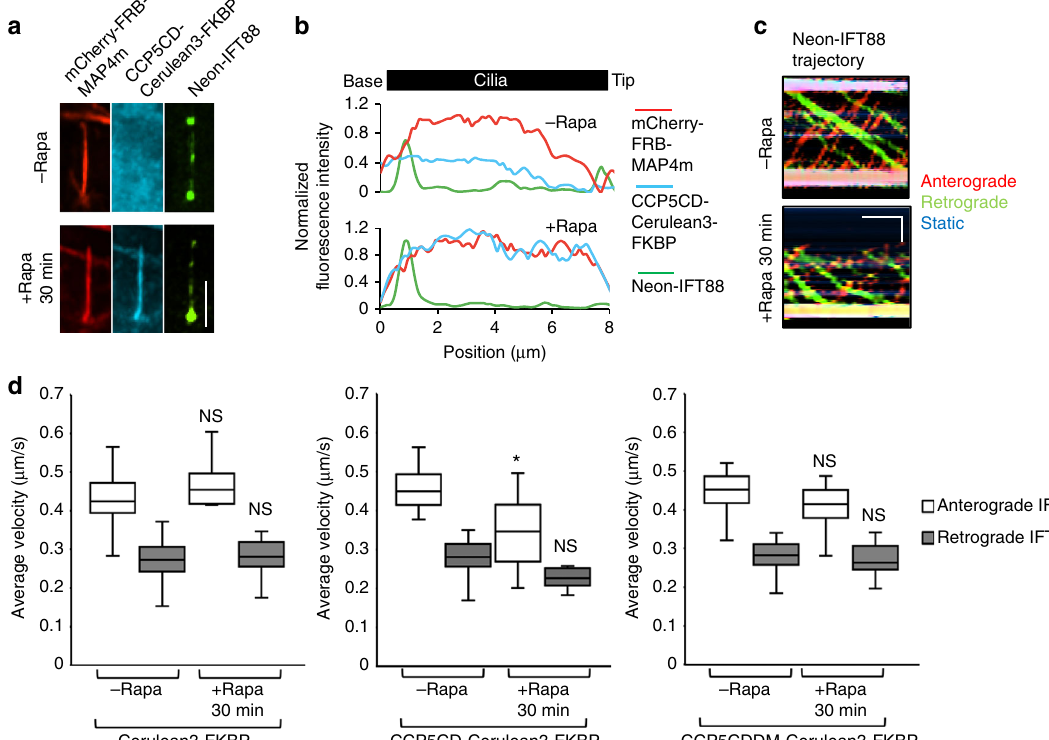
Fig. 4 Rapid axonemal deglutamylation preferentially hampers anterograde IFT. a Neon-IFT88 accumulates at the base of deglutamylated cilia. Neon-IFT88-stable NIH3T3 cells were transfected with CCP5CD – Cerulean3 – FKBP – P2A – mCherry – FRB – MAP4m. Transfected cells at 80 – 90% con fl uency were serum-starved for 24 h and then treated with 100 nM rapamycin for 30 min. Scale bar, 4 μ m. b Linescan pro fi le of the indicated proteins from base to the tip of the primary cilium in a . c Representative kymographs of Neon-IFT88 generated from time-lapse imaging of the cilium before and after rapamycin treatment for 30 min. Red, green, and blue lines represent the trajectories of Neon-IFT88 particles in anterograde and retrograde directions, and static Neon-IFT88, respectively. Horizontal scale bar, 10 s. Vertical scale bar, 2 μ m. Also, see Supplementary Movie 6. d Translocation of CCP5CD – Cerulean3 – FKBP, but not Cerulean3 – FKBP or CCP5CDDM – Cerulean3 – FKBP, onto the axoneme hampers the IFT only in the anterograde direction. Neon-IFT88-stable NIH3T3 cells were transfected with P2A-based constructs for co-expression of mCherry – FRB – MAP4m and Cerulean3 – FKBP- tagged proteins. Transfected cells at 80 – 90% con fl uency were serum-starved for 24 h and then treated with 100 nM rapamycin for the indicated times. The velocity of Neon-IFT88 was quanti fi ed according to the trajectories shown in the kymographs (see the Methods section; n = 175, 150, and 170 Neon- IFT88 particles for the Cerulean3 – FKBP, CCP5CD – Cerulean3 – FKBP, and CCP5CDDM – Cerulean3 – FKBP groups, respectively; three independent experiments). NS and * indicate no signi fi cant difference and P < 0.05, respectively, between the conditions in the presence or absence